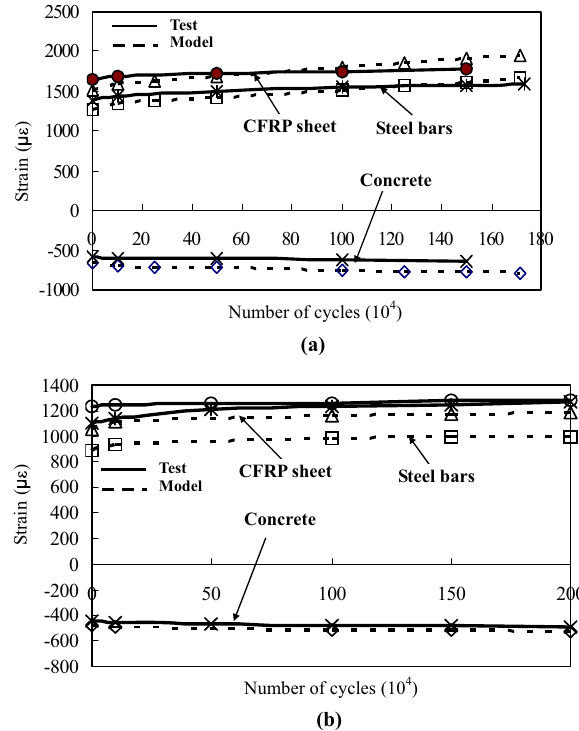
Fig. 4 Strain comparison of experimental and FAM results: a Beam1, b Beam